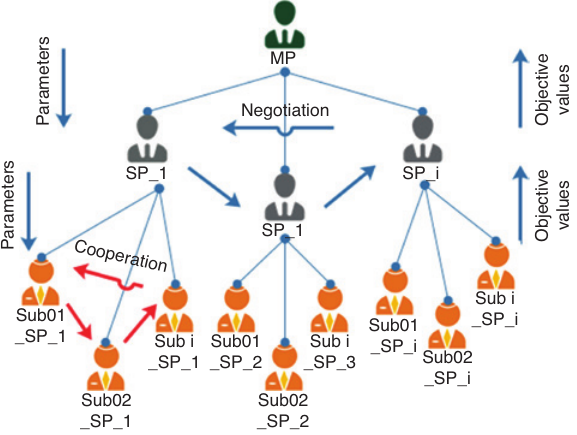
Figure 4: Master/Slave/Sub-slave